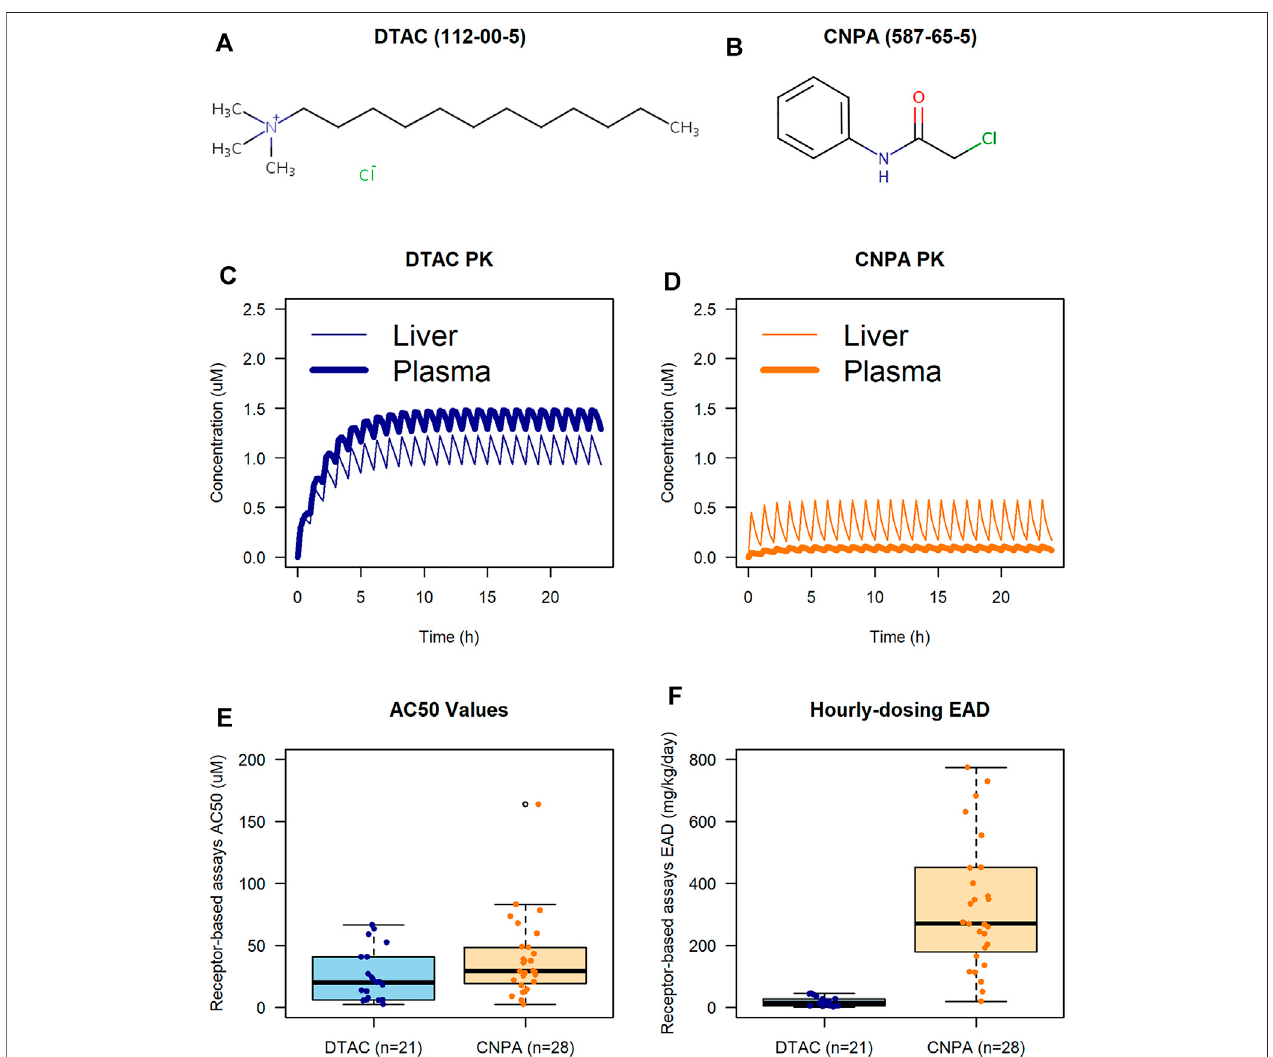
FIGURE 2| PBPK and IVIVE case study results conducted in ICE. Chemical structures for DTAC and CNPA are from the EPA CompTox Chemical Dashboard [ (A, B) , respectively; CAS numbers shown in parentheses]. PK pro fi les show plasma (bold) and liver (plain) concentrations during the simulation for DTAC and CNPA [ (C,D) , respectively].AC50boxplot (E) showssimilaritybetweenobservedbioactivityforreceptor-basedassaysinDTACandCNPA.Hourly-dosingEADboxplot (F) showshow ADME considerations can result in different EAD predictions for chemicals with similar in vitro bioactivity.